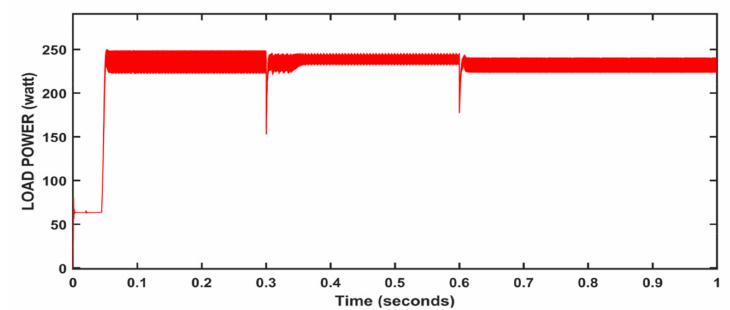
Figure 21. FLC output power under constant irradiations and variable loads.